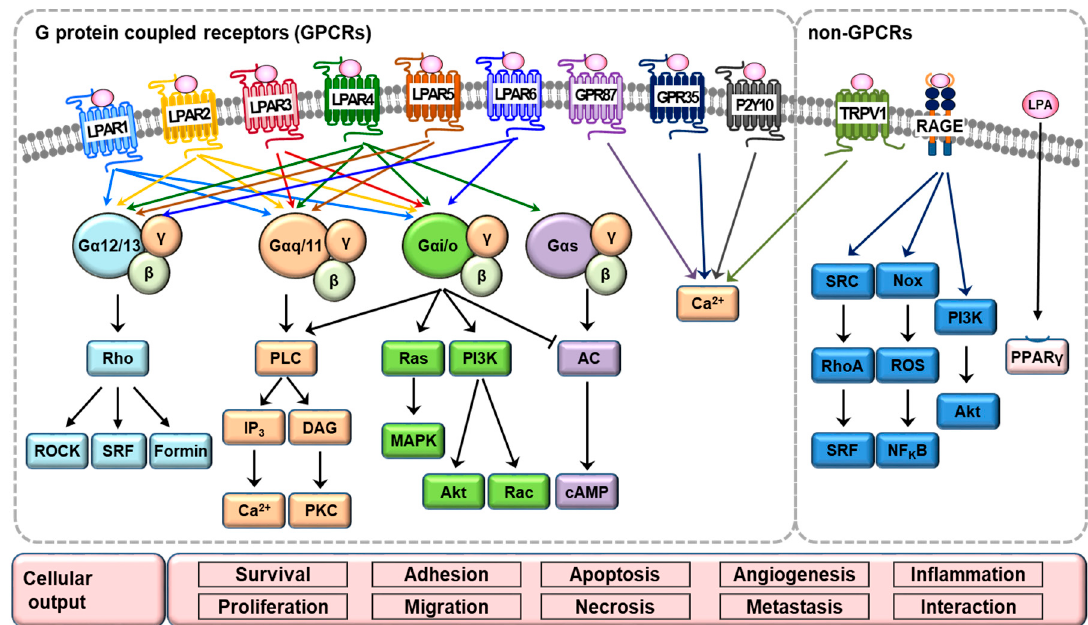
Figure 2. LPA signaling pathways. LPA can induce multiple cellular effects via binding to specific GPCRs, including LPAR1–LPAR6, as well as binding to non-GPCRs, such as transient receptor